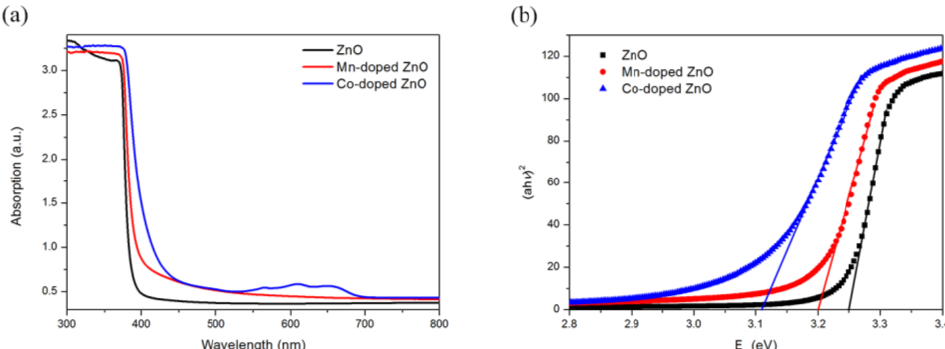
Figure 4. ( a ) UV-Vis spectra of ZnO, Mn-doped ZnO and Co-doped ZnO; ( b ) bandgap calculation figure.